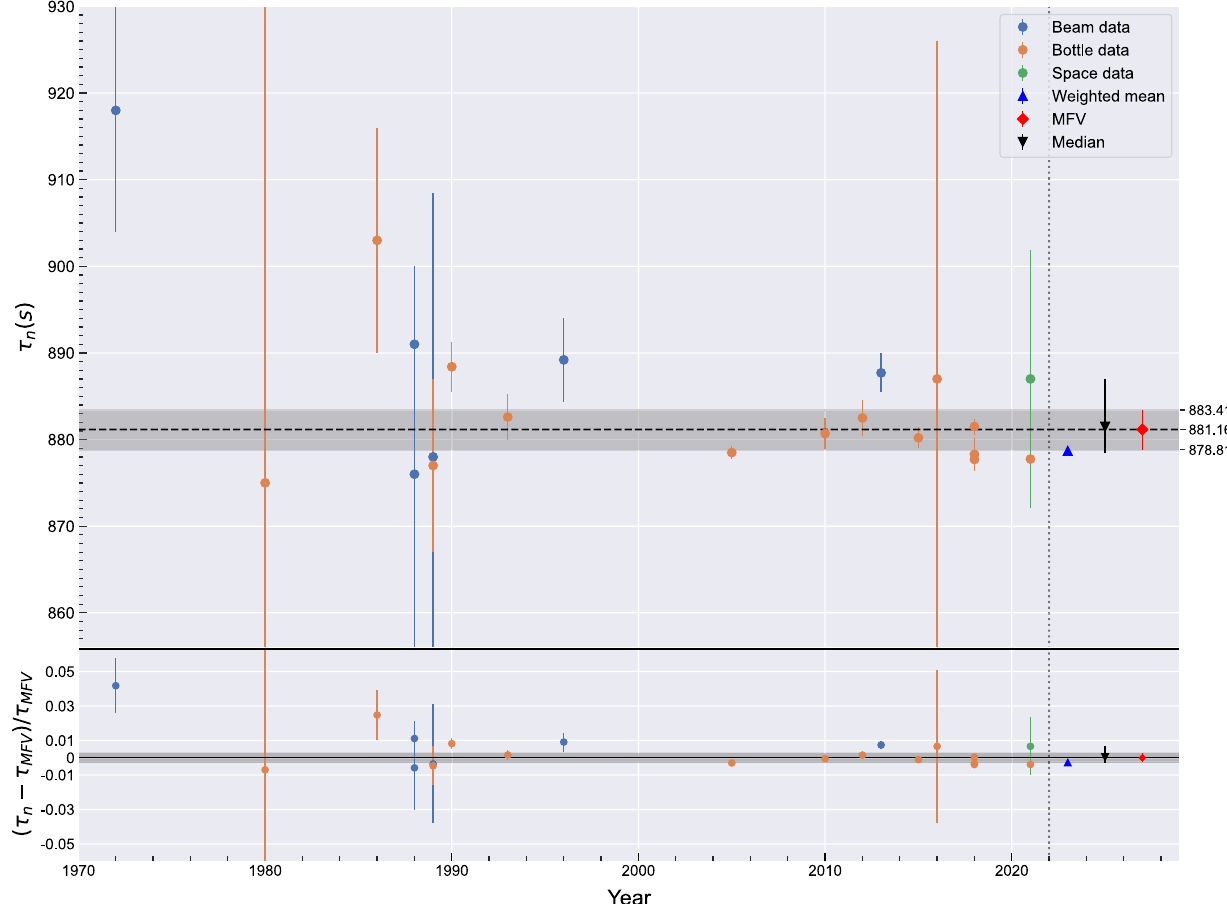
Fig. 8 (Top) Neutron lifetime measurements as a function of publi- cation date. The points are the measured data using bottle, beam, and space-based methods, while the triangle, diamond, and inverted triangle